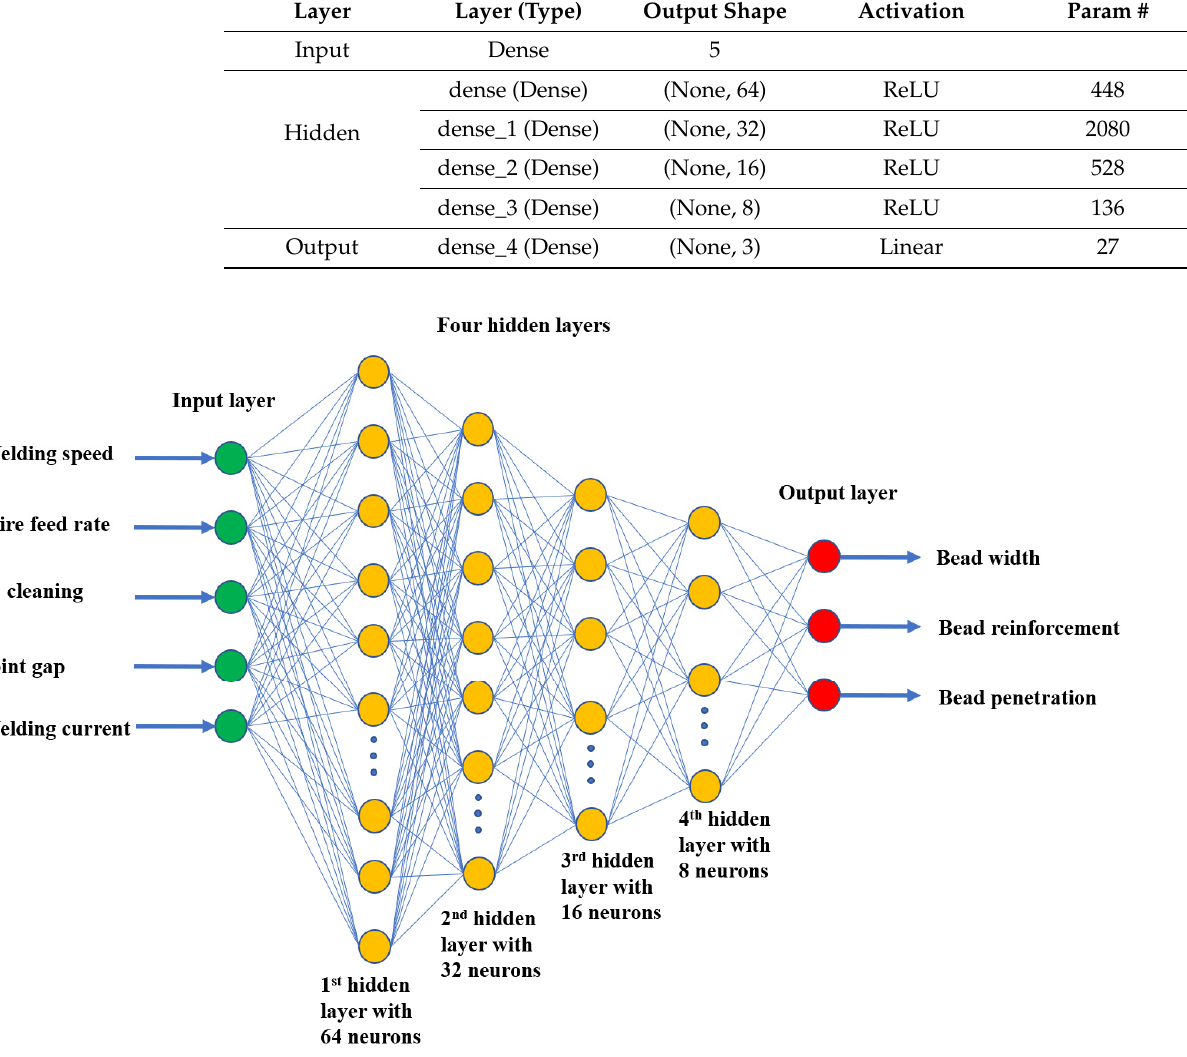
Figure 6. Deep learning neural network architecture for the TIG welding process.